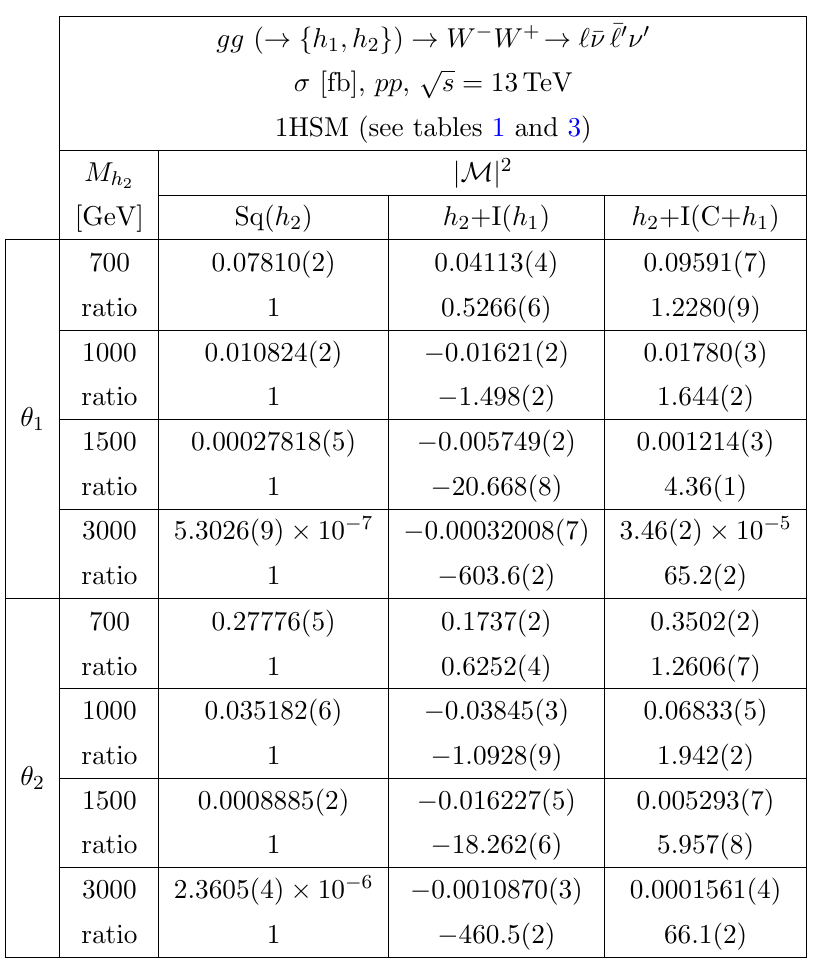
Table 5 . Cross sections for gg ( in the 1HSM with focus on heavy Higgs ( h 2 ) production. The ratio (cid:27)=(cid:27) (Sq( h 2 )) is also given. Other details as in table